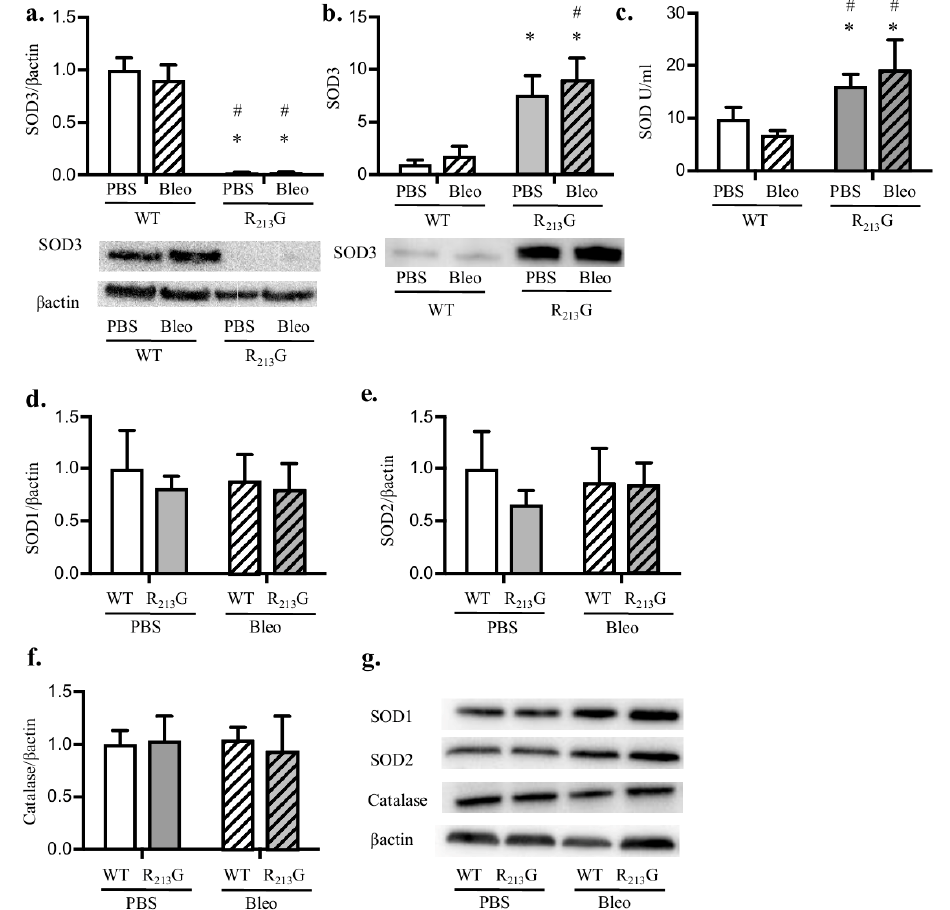
Figure 4. Bleomycin does not change R 213 G redistribution of SOD3. SOD3 protein content in the lung and serum was evaluated by western blot analysis in WT and R 213 G mice at 22 days of age after exposure to PBS (10 μ L for 9 doses) or bleomycin (3 units/kg/dose dissolved in 10 μ L of PBS for 9 doses). 25 μ g lung protein or 2 μ L serum was loaded onto the gels. ( a ) Lung SOD3 ( b ) Serum SOD3. Representative blots for Figure 4a and 4b are shown along with optical density normalized to β -actin and expressed relative to WT control mice. SOD activity was measured in serum. ( c ) Serum SOD Activity (units per ml). Several other key antioxidant enzymes were evaluated in the lung by western blot analysis. Representative blots are shown along with optical density normalized to β -actin and expressed relative to WT mice ( d ) Lung SOD1 ( e ) Lung SOD2 ( f ) Lung catalase. ( g ) Representative blots for SOD1, SOD2, catalase and β -actin. * p < 0.05 vs. WT PBS, # p < 0.05 vs. WT Bleo, all analysis by two-way ANOVA, n = 5–6 for all groups.